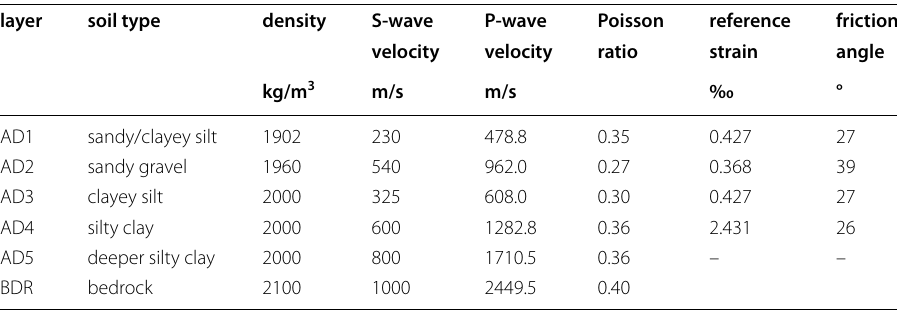
Table 3 Geotechnical parameters for each soil layer